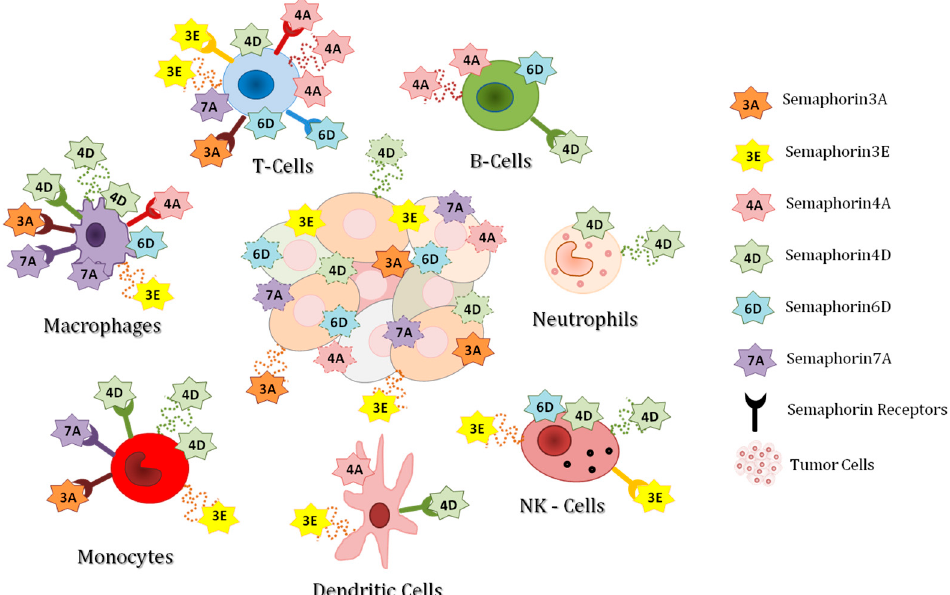
Figure 1. Highlighted in the cartoon are major semaphorin signals potentially relevant for the regulation of diverse inflammatory and immune cells found in the tumor microenvironment. Semaphorins are in fact produced by both cancer cells and cells recruited from the circulation in the inflammatory process. Dotted connecting lines indicate semaphorin molecules secreted or proteolytically shed from the cell surface. Ligand-engaged transmembrane receptors illustrate known autocrine/paracrine signaling mechanisms. Membrane anchored semaphorins might provide juxtacrine proximity signals to neighboring cells (not depicted in the cartoon, for sake of simplicity). A very complex network of signals between different cells in the tumor microenvironment is therefore envisaged. The drawing also summarizes several evidences about semaphorin signaling in normal immune response, the relevance of which in cancer context needs to be assessed. Notably, while for Sema4D there is a consensus on its pro-tumorigenic role, and the multifaceted activity of Sema3A in the tumor microenvironment is under intense investigation, for other immuno-semaphorins, more experimental data are warranted to understand whether they act in cancer-related inflammation as promoters or suppressors.